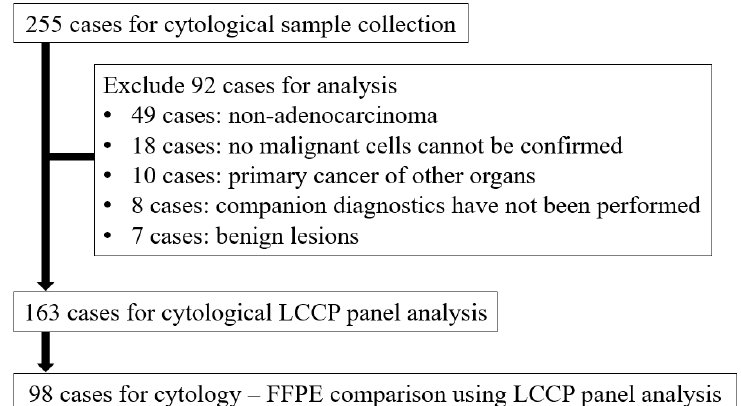
Figure 2. Flow diagram of sample selection. FFPE: Formalin-fixed paraffin-embedded, LCCP: Lung cancer compact panel.